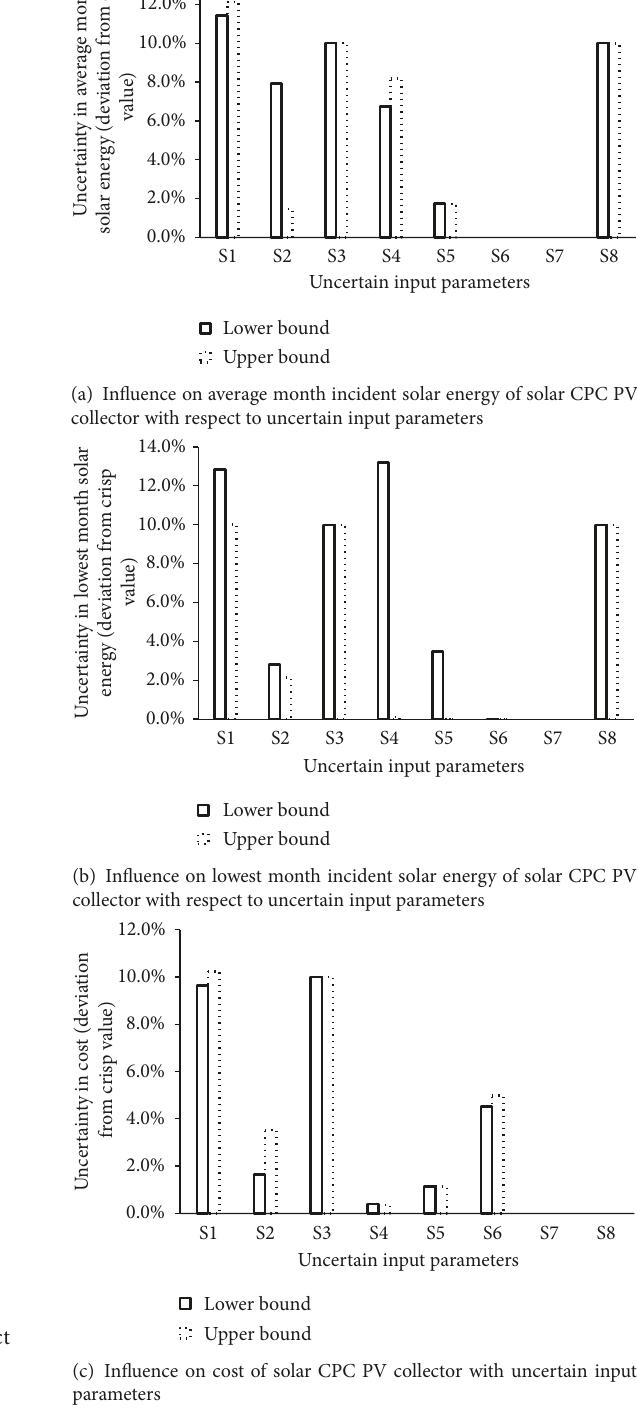
Figure 7: Influence on cost of solar CPC PV collector with respect to uncertain input